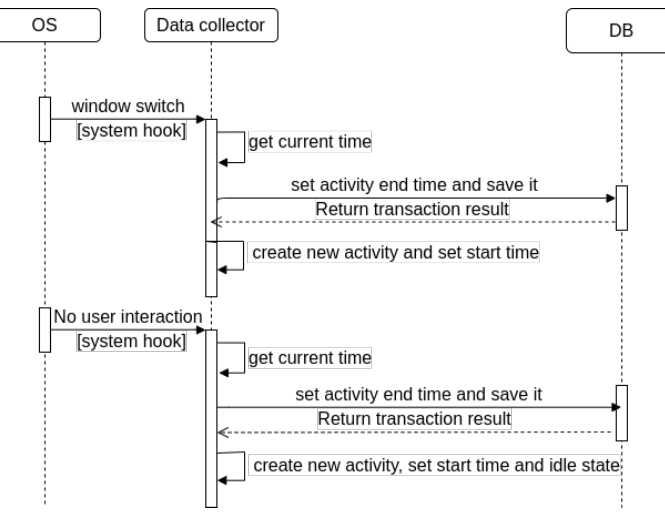
Figure 4. Collecting user activity data sequence